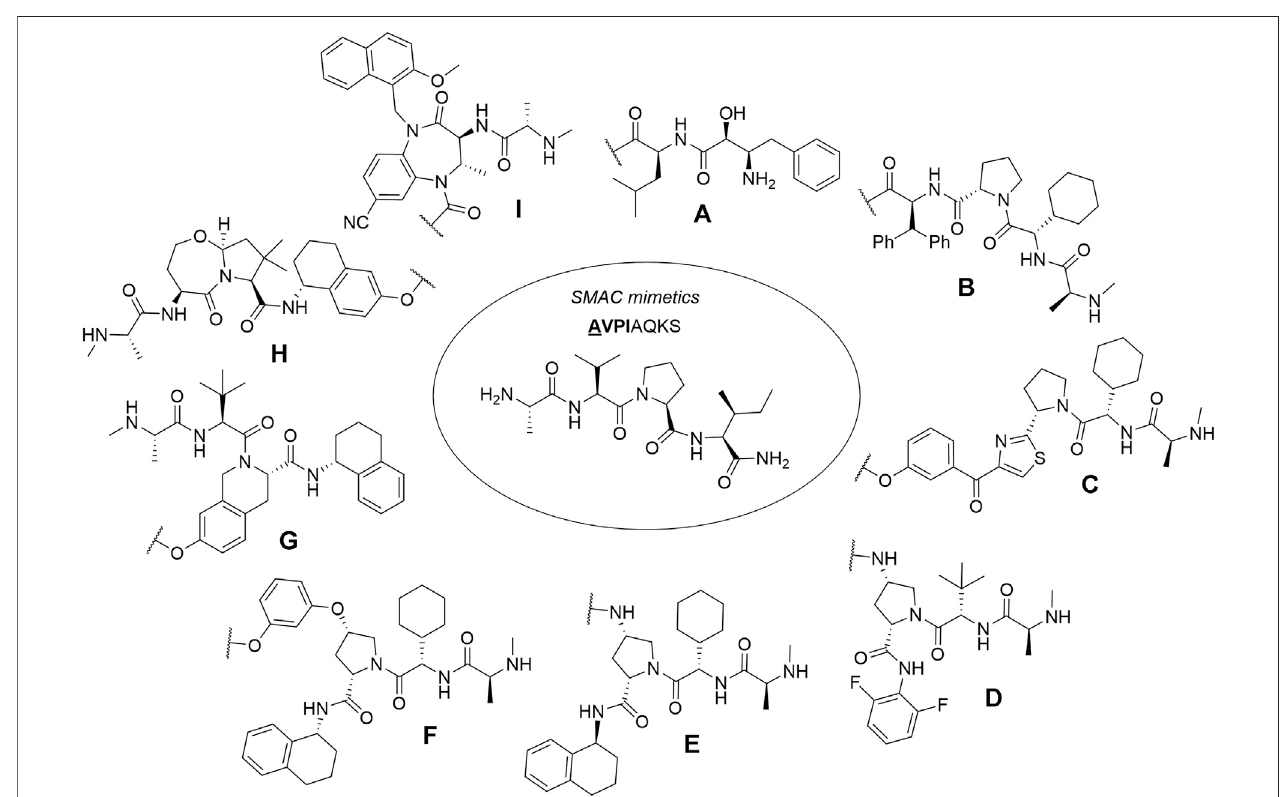
FIGURE6| IAPligands.IAPligand (A) (bestatin),IAPligand (B) (MV1derivative),IAPligand (C) (LCL - 161derivative),IAPligand (D) (Cmpd37 derivative),IAPligand (E) (A410099 derivative), IAP ligand (F) , IAP ligand (G) , IAP ligand (H) (SBP-0636457 derivative), IAP ligand (I) .